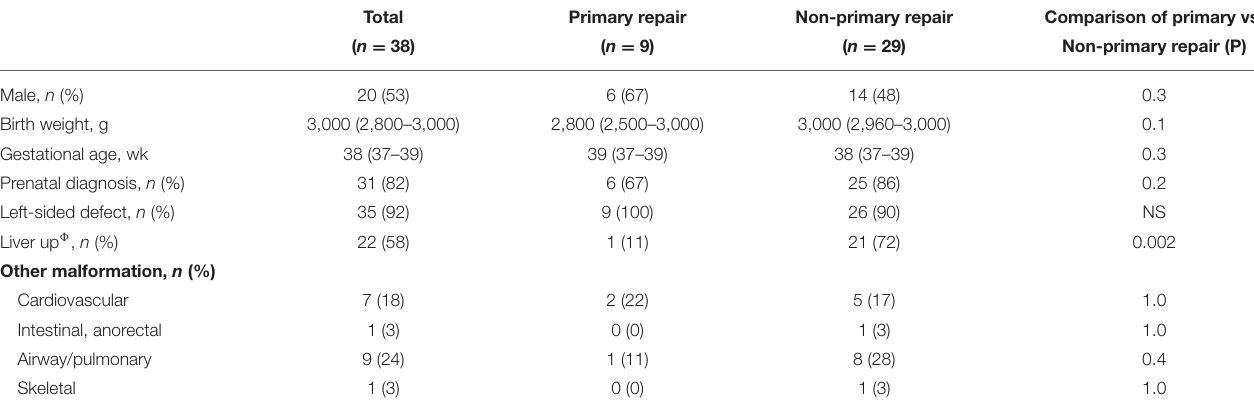
TABLE 1 | Patient demographics.